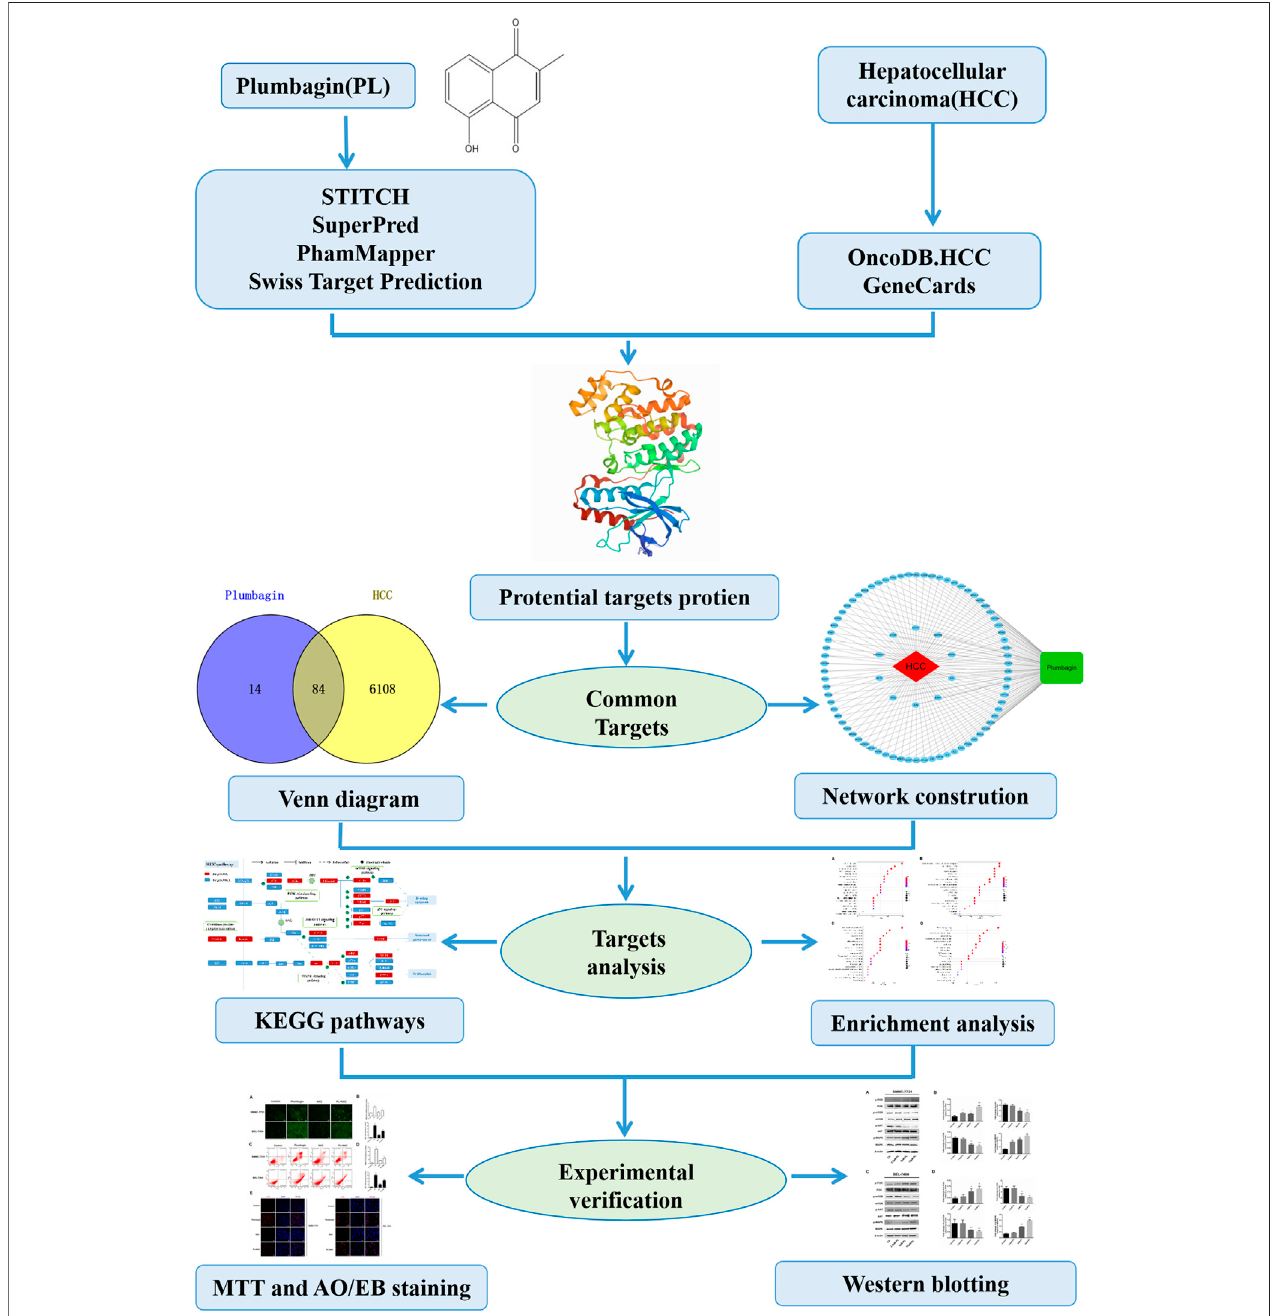
FIGURE 1 | Systems pharmacology approach work fl